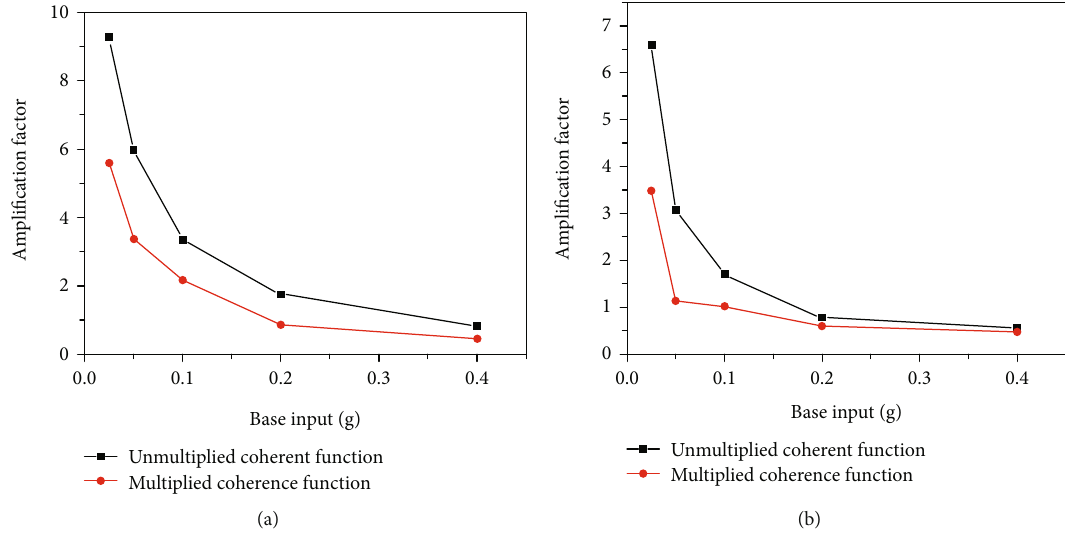
Figure 10: Ampli fi cation factor comparison chart of the unmultiplied coherent function and multiplied coherent function for di ff erent conditions (model 2 for the surface with water): (a) fi rst-order mode and (b) second-order